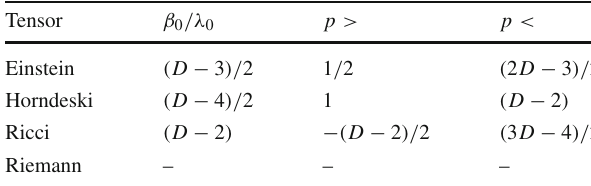
equation and the analise could be done only asymptotically. Table 1 The localizability condition for the p -forms fields